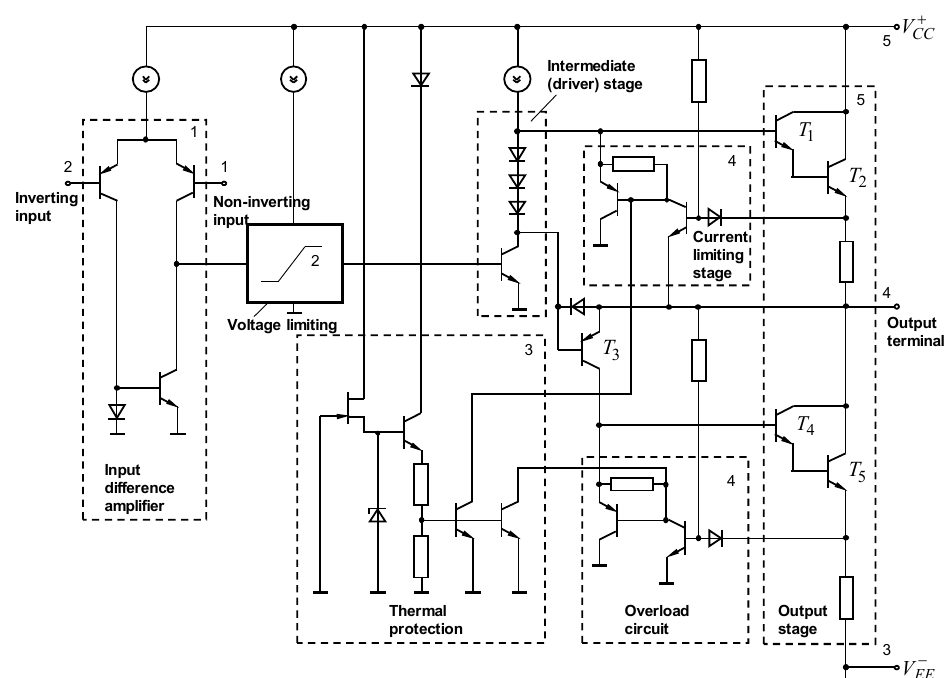
Figure 1. A simplified circuit diagram of a TDA2030 from TDA-series power amplifiers [14,15]. Based on the simplified circuit diagram in Figure 1, a block diagram of the proposed